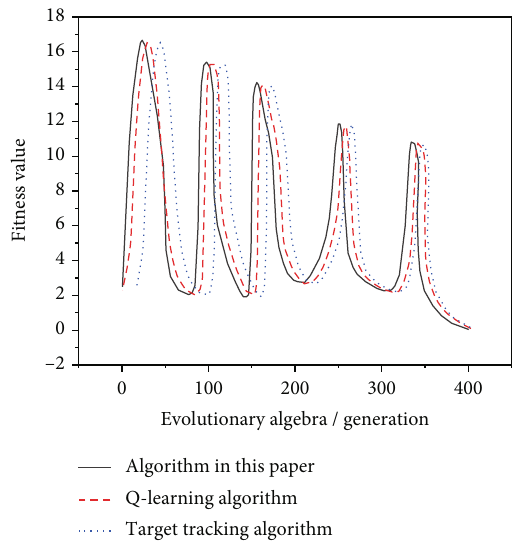
Figure 6: Evolution process of moving into the circle.